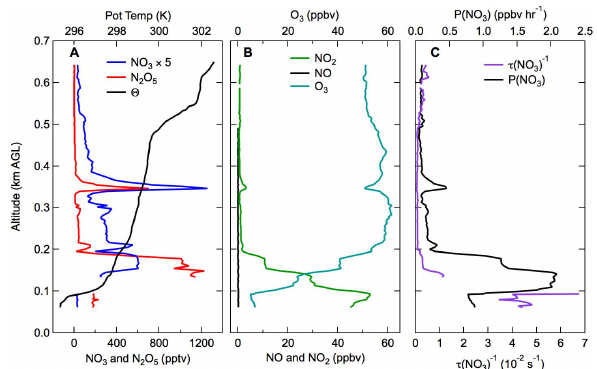
Fig. 12. Vertical profile of (A) mixing ratios of NO 3 ( × 5 to make it visible) and N 2 O 5 (bottom axis) and potential temperature (top axis); (B) mixing ratios of NO and NO 2 (bottom axis) and O 3 (top axis); (C) NO 3 reactivity, measured as τ (NO 3 ) − 1 (bottom axis), and production rate P (NO 3 ) (top axis). Data are for descent to Lone Star on 12 October, 00:37 local time.